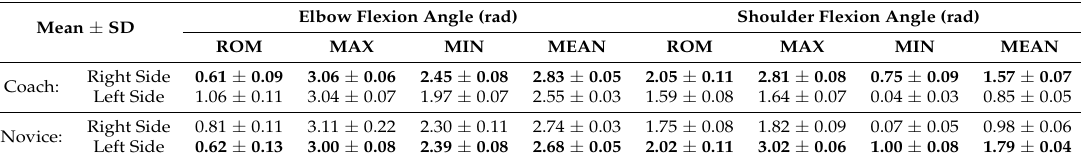
Figure 16. The joint flexion angle extension variation of coach on both sides of the body. Table 3. Evaluation of joint angle